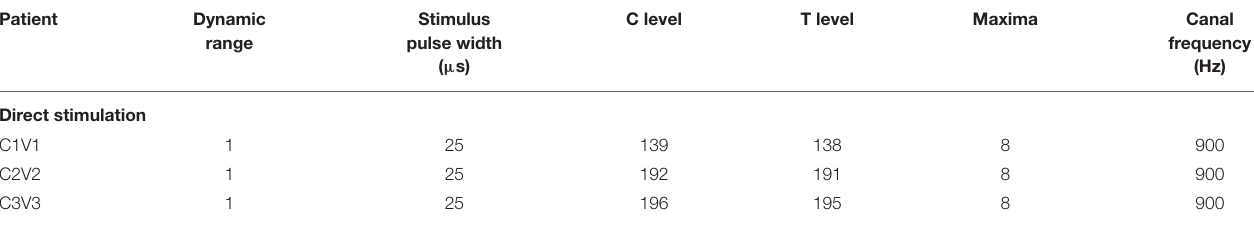
TABLE 4 | Characteristics of the dynamic range of each of the patients in group 1 (vestibular implant).